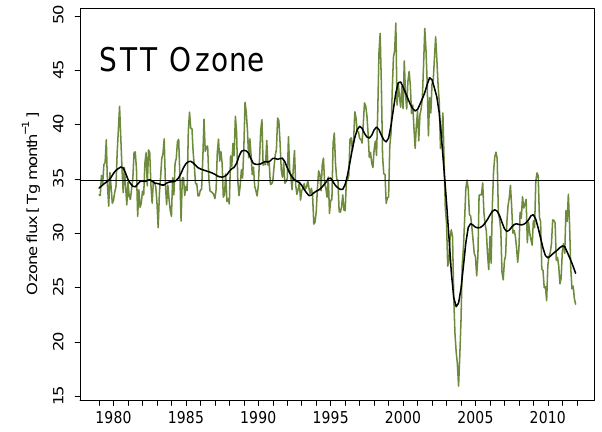
Fig. 19. Time series of the globally integrated STT ozone flux (monthly averages) from 1979 to 2011. The bold line shows a 12- month moving average and the mean value of the whole time series is indicated with a horizontal